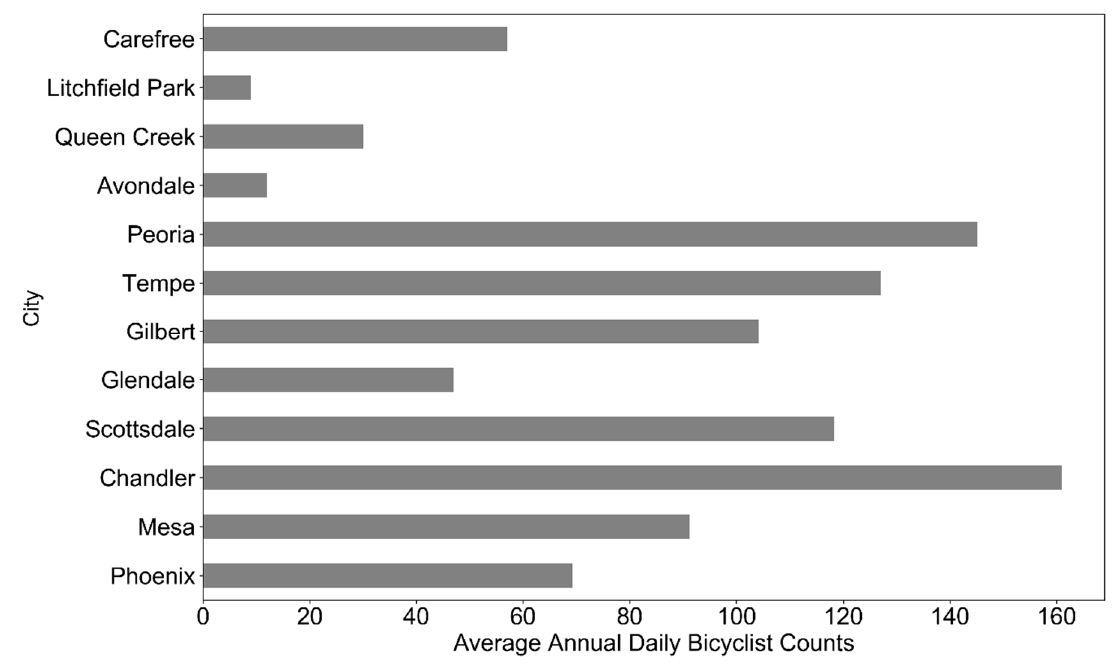
Figure 2. Average annual daily bicyclist counts in Maricopa County in 2016.